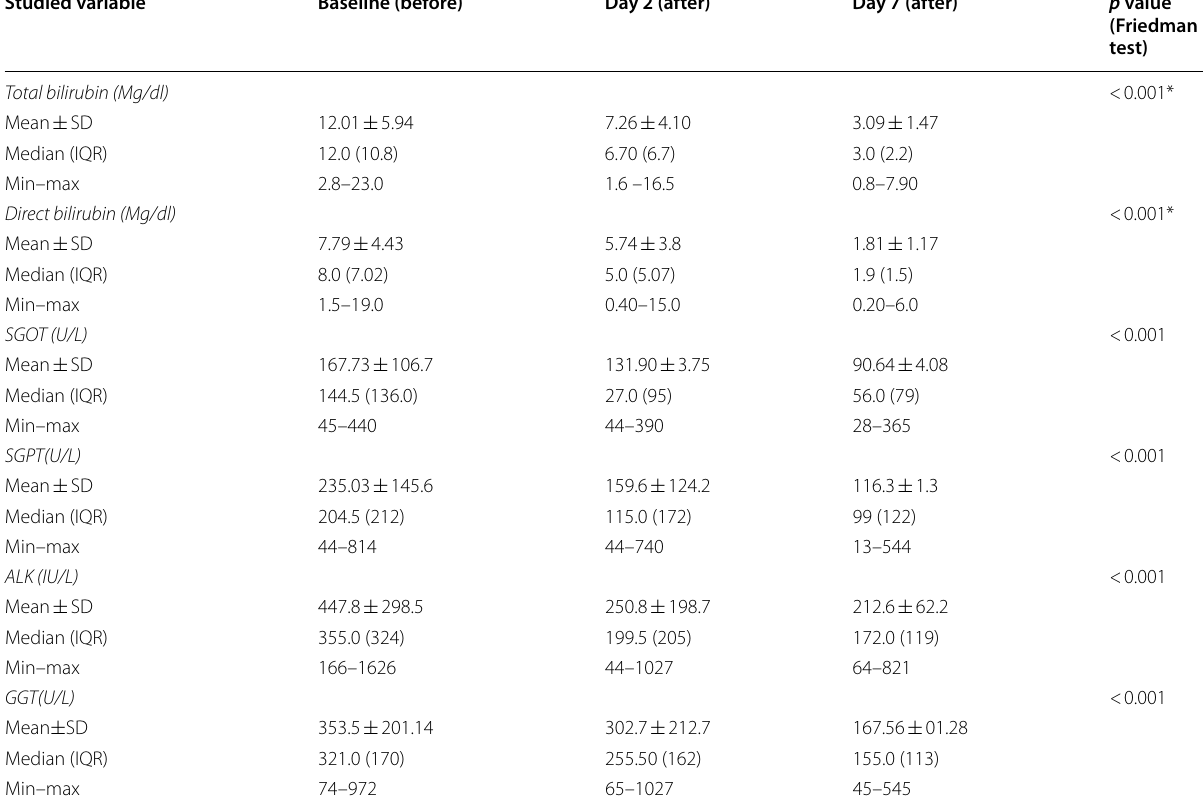
Table 2 Changes in laboratory data, measured before and after biliary drainage Studied